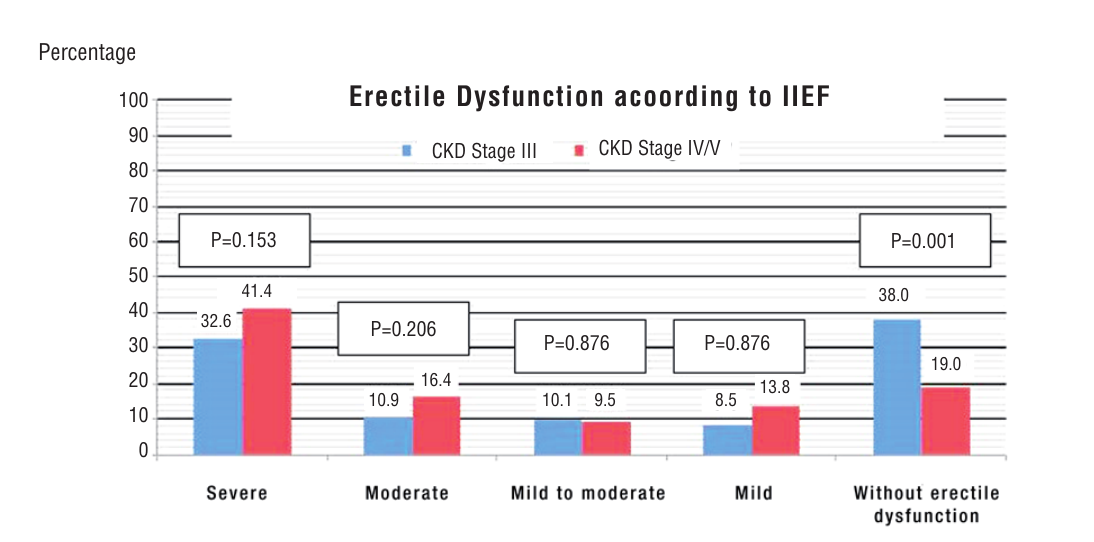
Figure 5 - Comparison of category of erectile dysfunction among patients with chronic kidney disease on conservative treatment in stage III versus Iv/v. Estimated by chi-square test; P =Statistical significance; CKD =Chronic Kidney Disease; IIEF =International index of erectile function.